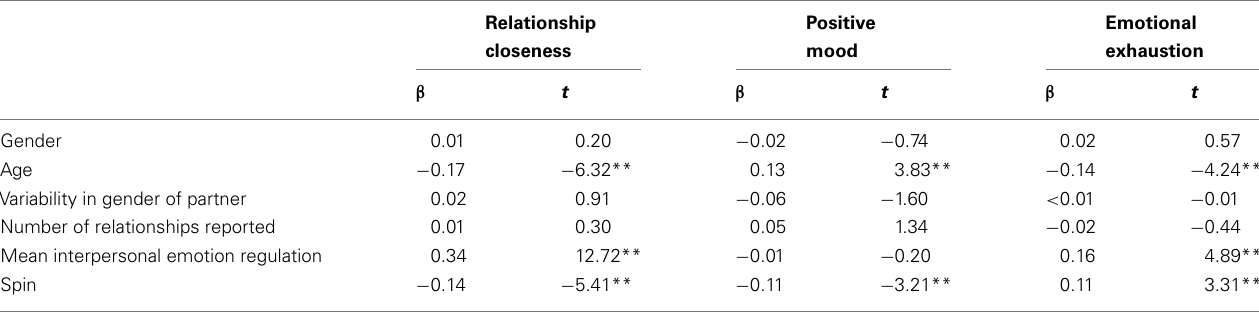
Table 4 | Regression of spin onto relationship closeness, positive mood, and emotional exhaustion.